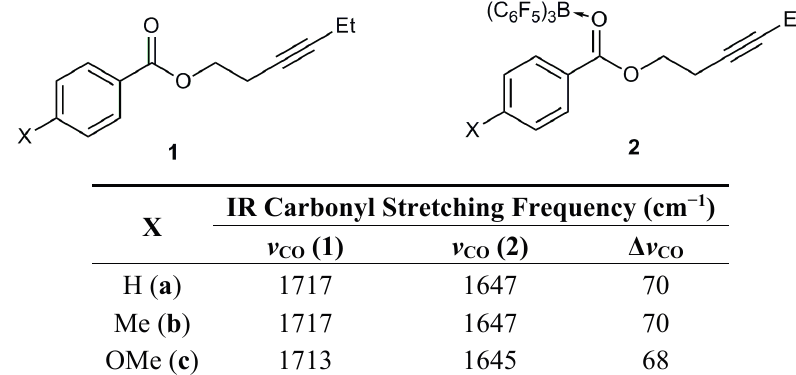
Table 1. IR stretching frequencies for free and coordinated alkynyl